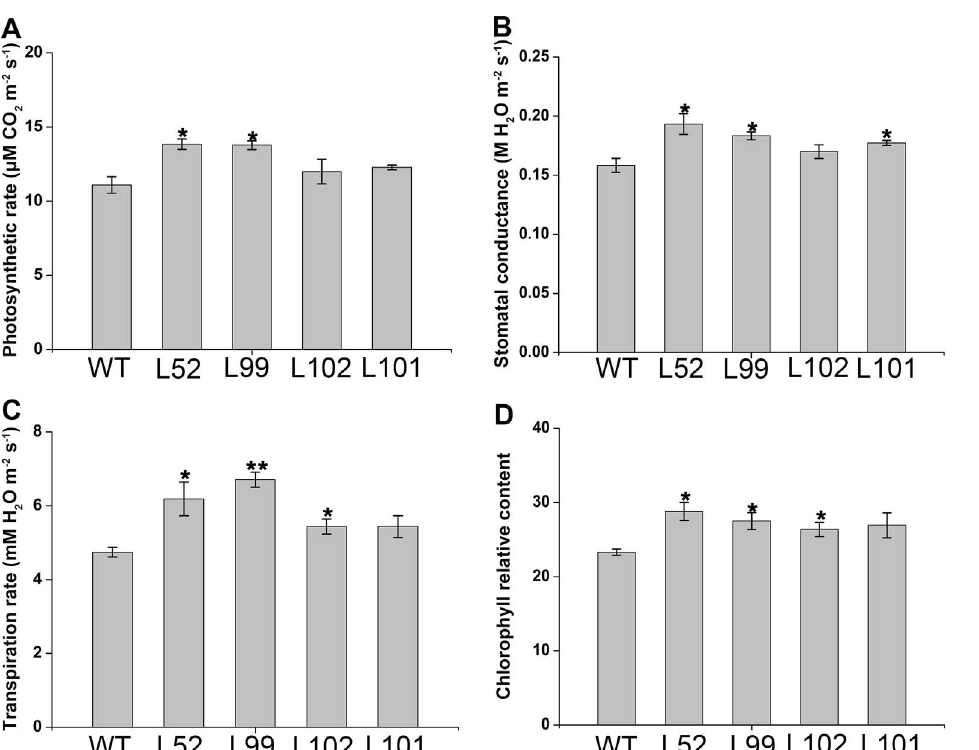
Fig. 9. Photosynthetic performance of the IbMas -overexpressing sweetpotato plants under salt stress. (A), (B), (C) and (D) Photosynthetic rate, stomatal conductance, transpiration rate and chlorophyll relative content, respectively, in the leaves of salt-tolerant transgenic plants (L52, L99, L102 and L101) and wild-type plant (WT). The 25-cm-long cuttings of the salt-tolerant transgenic plants evaluated with water culture assay and WT were grown in 19- cm diameter pots containing a mixture of soil, vermiculite and humus (1:1:1, v/v/v) in a greenhouse, with one cutting per pot. All pots were irrigated sufficiently with half-Hoagland solution for 10 days until the cuttings formed new leaves, and then each pot was irrigated with a 200 mL of 200 mM NaCl solution once every 2 days for 2 weeks. Data are presented as means ¡ SE (n 5 3). * and ** indicate a significant difference from that of WTat P , 0.05 and , 0.01, respectively, by Student’s t